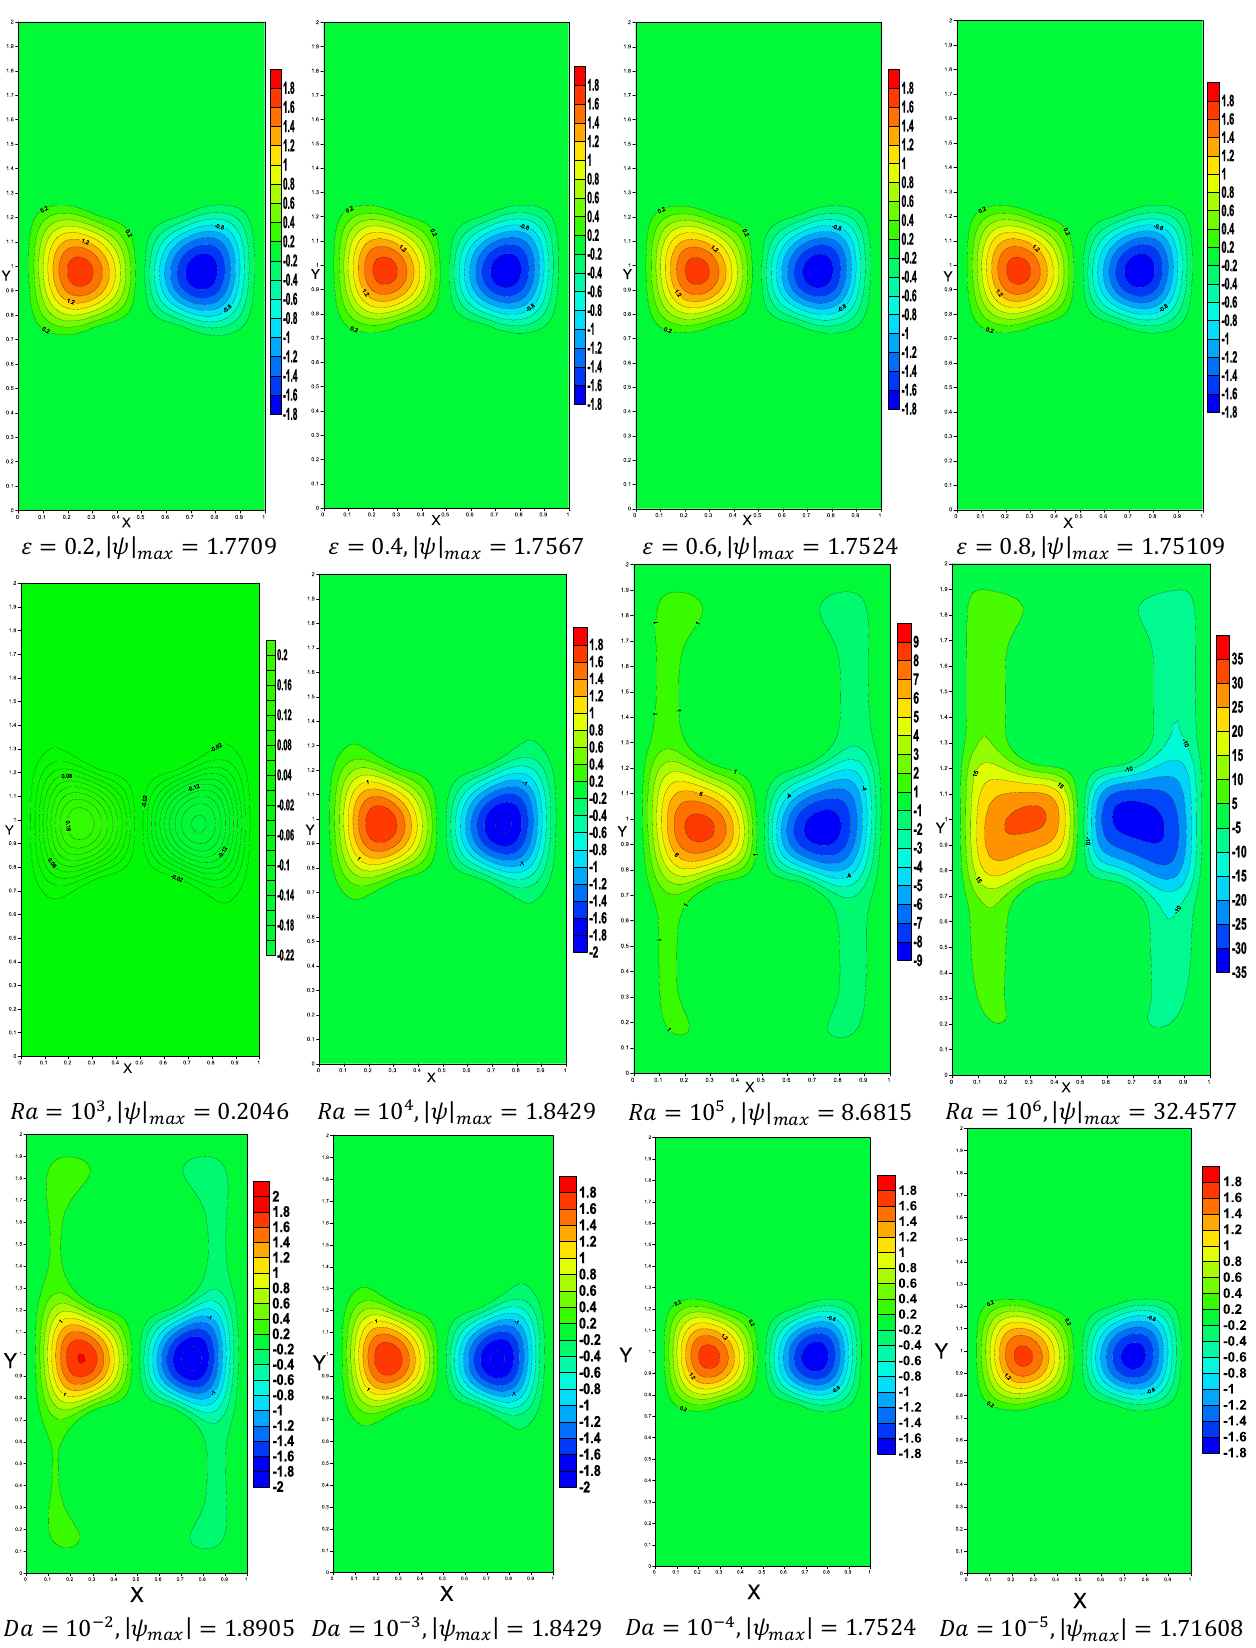
Figure 4. The streamlines below the variations of the shape of superellipse enclosures, porosity, Rayleigh number, and Darcy number,